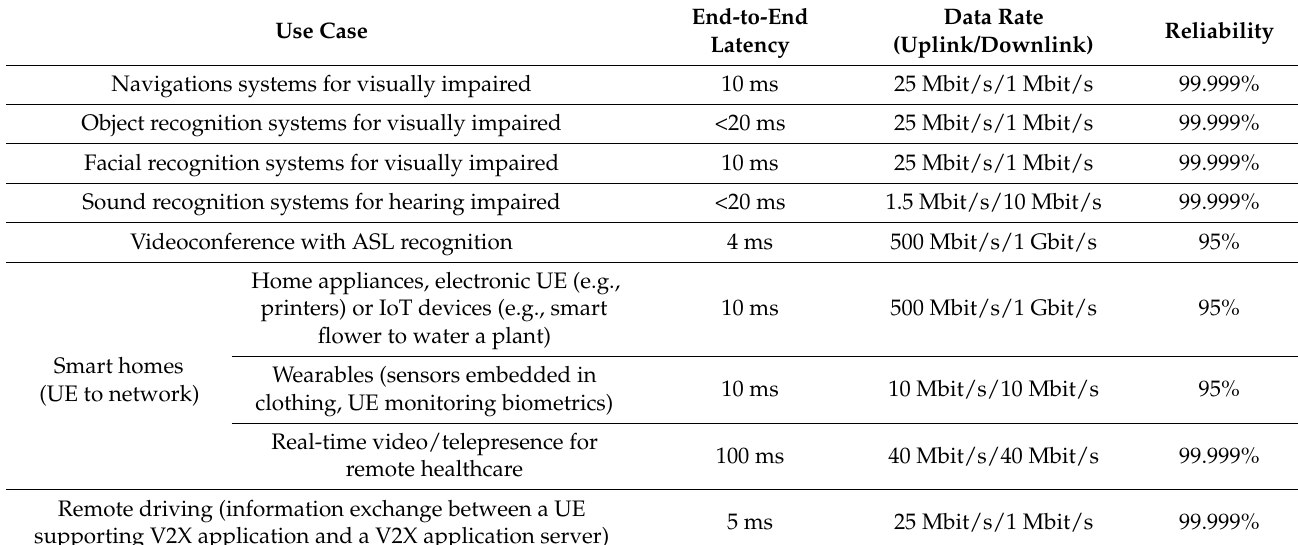
Table 1. KPIs of the different use cases for people with disabilities